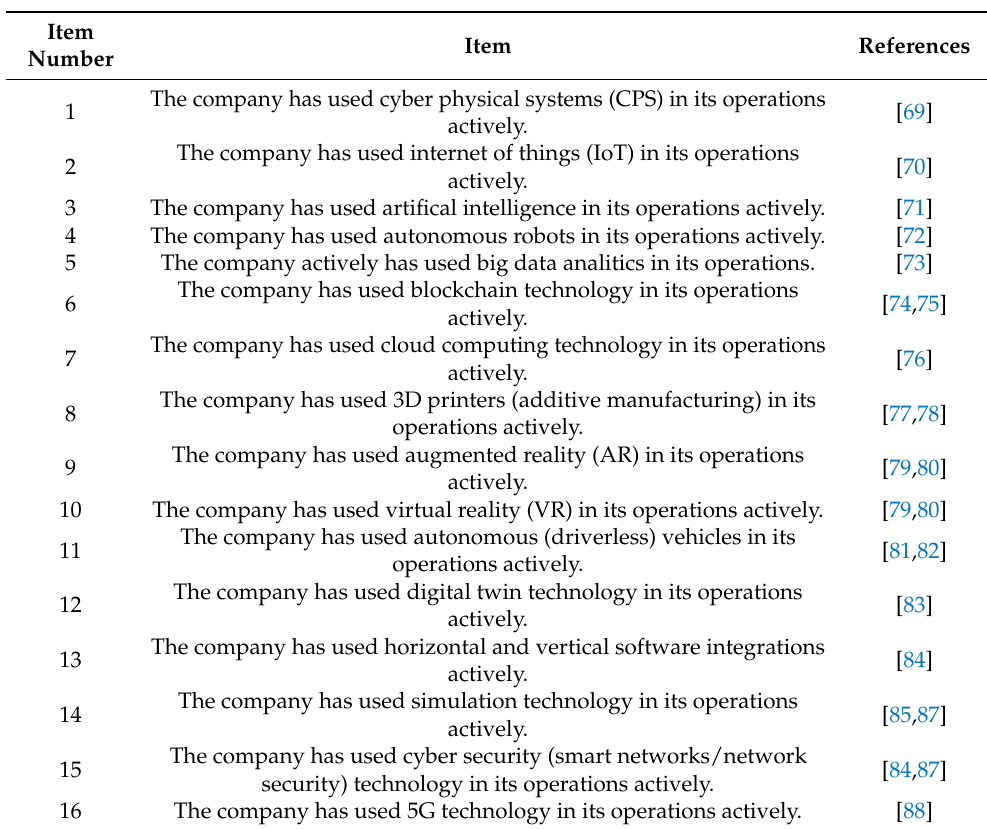
Table A2. Item Pool for the Pilot